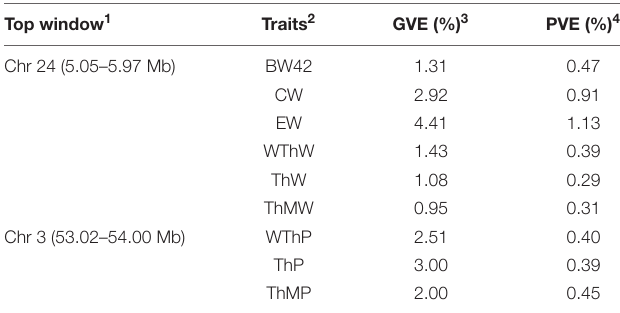
TABLE 3 | genetic variance and phenotypic variance explained by top 1-Mb windows for all traits using Bayes C π . Top window 1